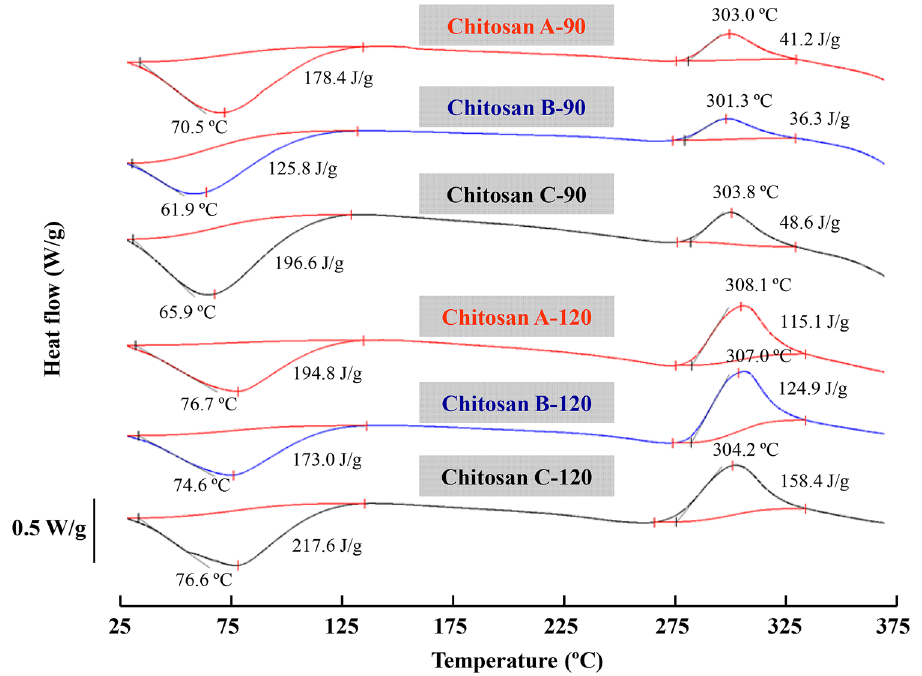
Figure 5. DSC curves of crab shell chitosan by deacetylation at 90 °C and 120